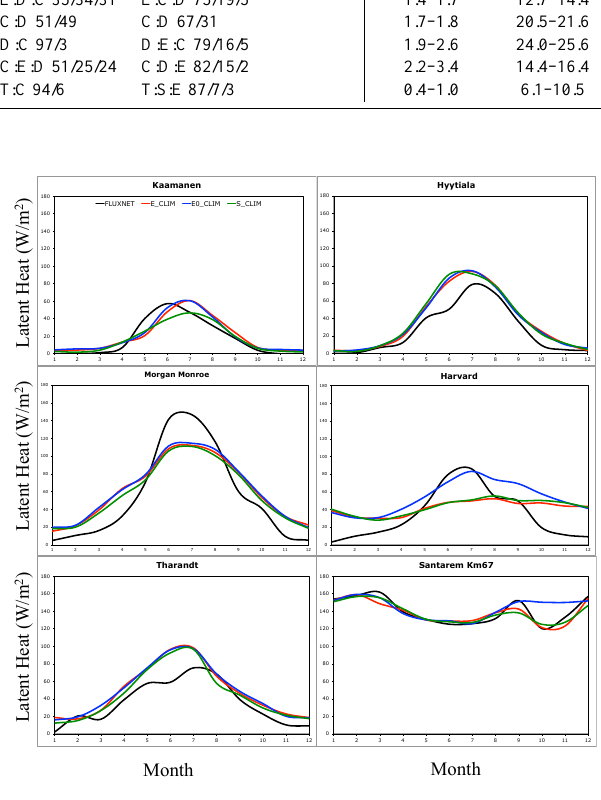
Fig. 5b. Comparison of measured and modeled latent heat flux at 6 Figure 5(b). Comparison of measured and modeled latent heat flux at 6 FLUXNET sites (W/m 2 ). FLUXNET sites (Wm − 2